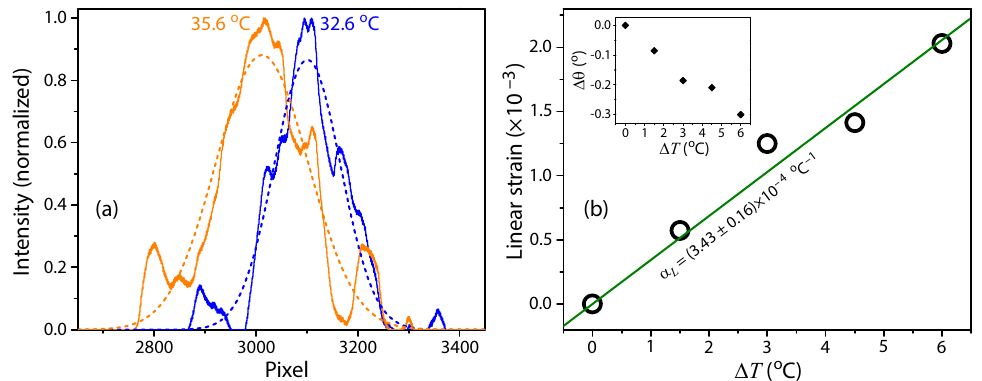
Figure 2. ( a ) The solid lines show the intensity profile of the n = + 1 diffracted beam incident on the surface of the linear CCD array. Gaussian fits to both experimental intensity profiles are given by the dashed lines. ( b ) A straight line was fitted to the linear strain as a function of temperature. The strain was determined from the change in the diffraction beam’s angle shown in the lower left inset. The upper right inset shows the peak position of the Gaussian fits as a function of temperature used to determine the angle of the diffraction